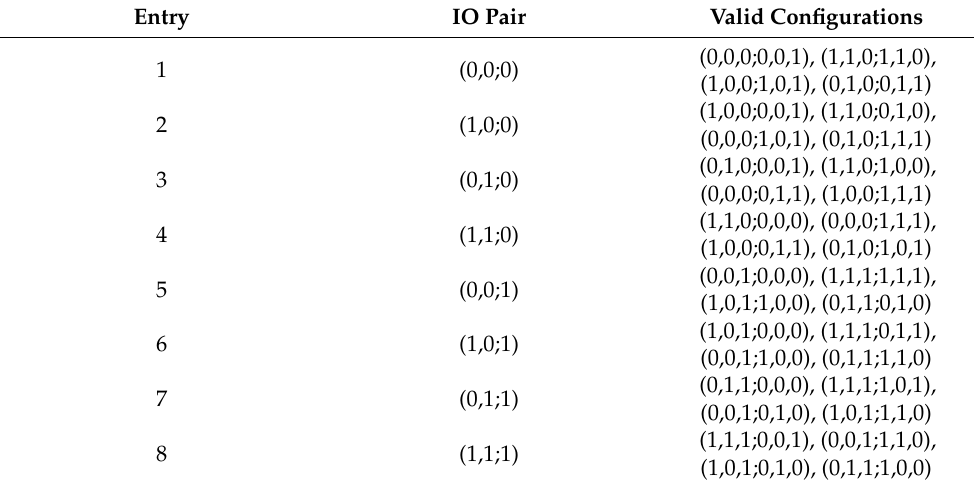
Table 1. Each kind of input/output pair for a faulty NAND is described. Each entry has different valid configurations, and configurations in the same entry form a subspace such that the action of the driver terms we construct connects the configurations of this